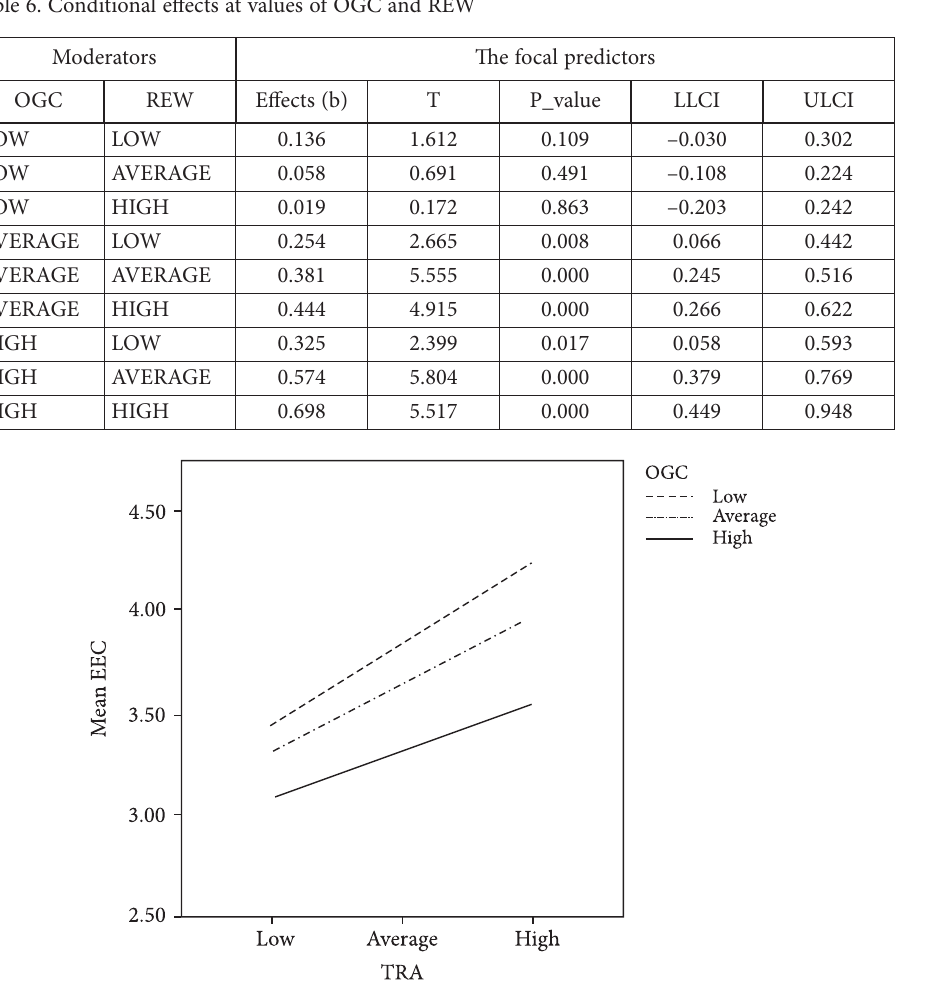
Figure 2. The conditional effect in